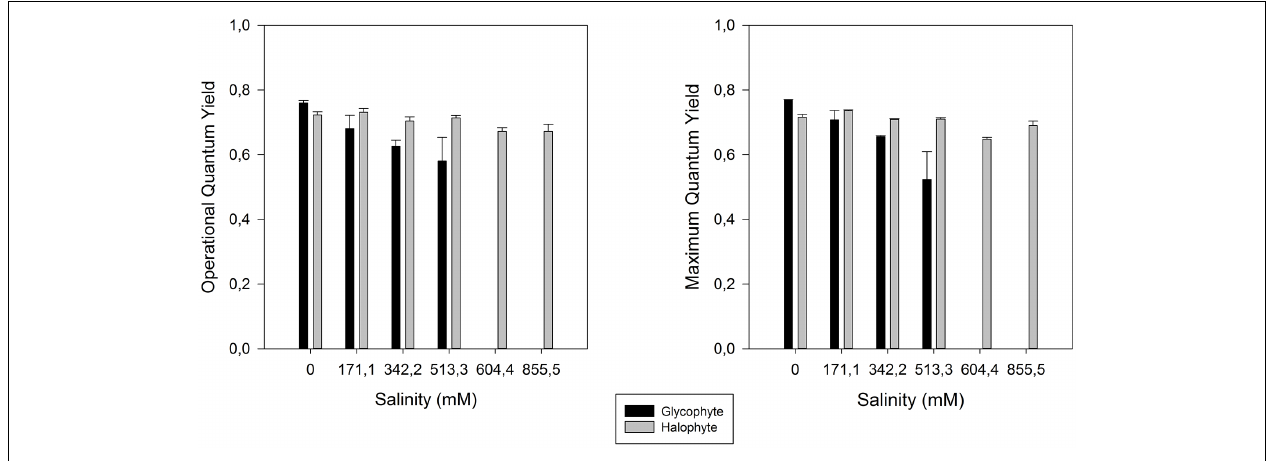
FIGURE 4 | Operational and maximum PSII efficiency in glycophyte Cyperus longus and in halophyte Spartina patens along a salinity gradient (average ± SE, N = 5).